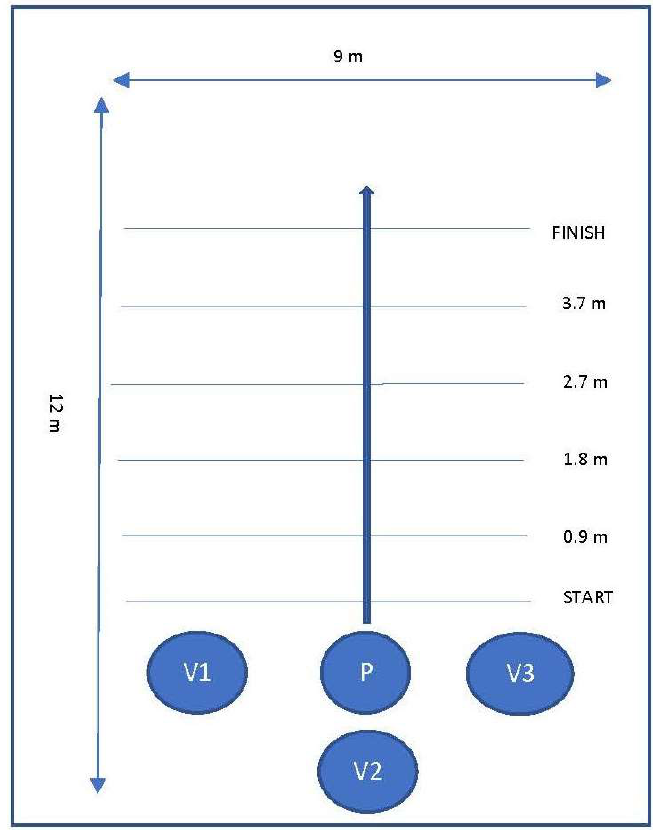
Figure 2. Diagram of layout used for data collection under each condition. Participant (P) was positioned behind the start line, to ensure they were in full stride by the time they hit the first joint angle measurement line (0.9 m). Participants were instructed to continue walking until they passed the finish line, to ensure that their kinematics were not impacted artificially by coming to a stop before the final joint measurement line (3.7 m). Researchers with iPhones (V1, V2, V3) were positioned to the left, right, and immediately behind the participant, and moved at the same speed as the participant throughout each condition.